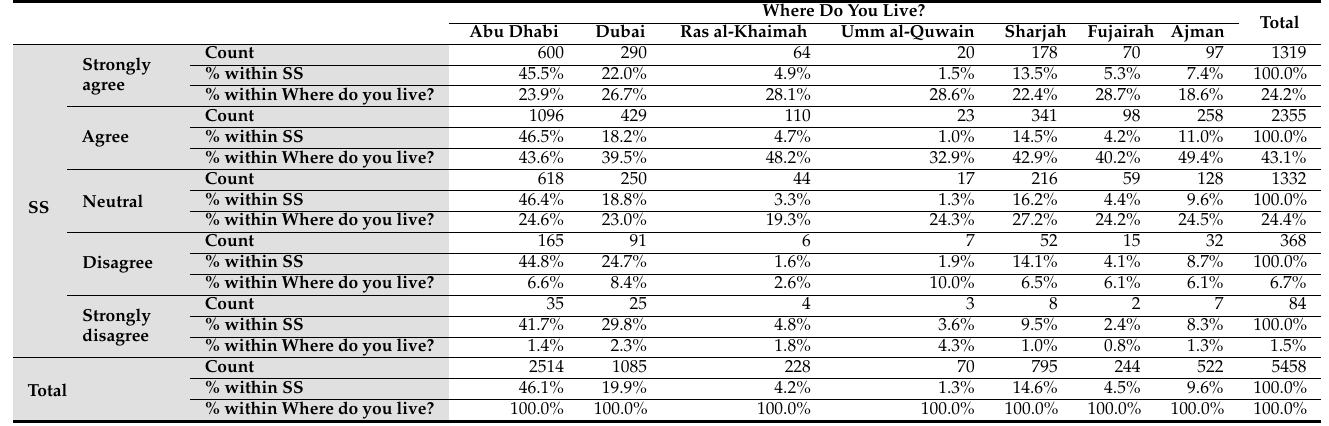
Table 28. Symbolic societal value of EVs and respondents’ emirates cross-tabulation. Where Do You